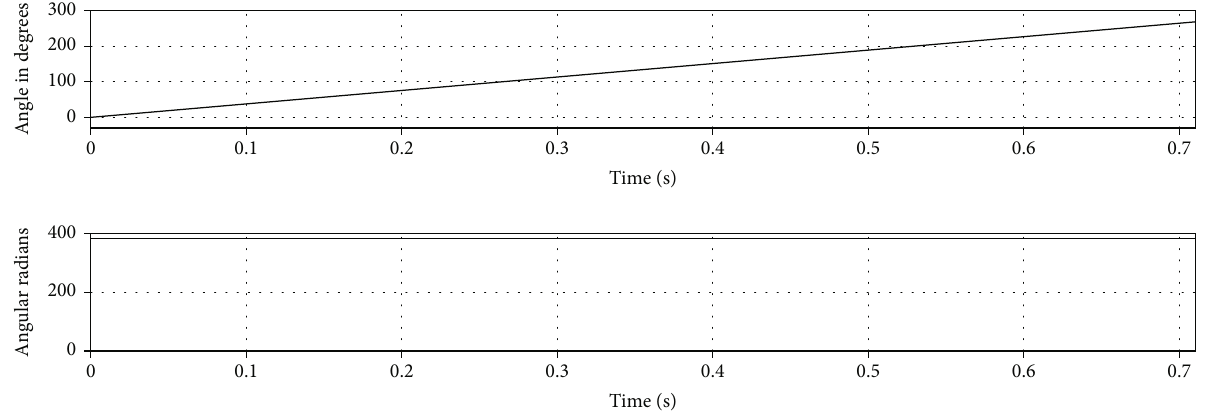
Figure 14: Angular radians and radians/sec for DER1.